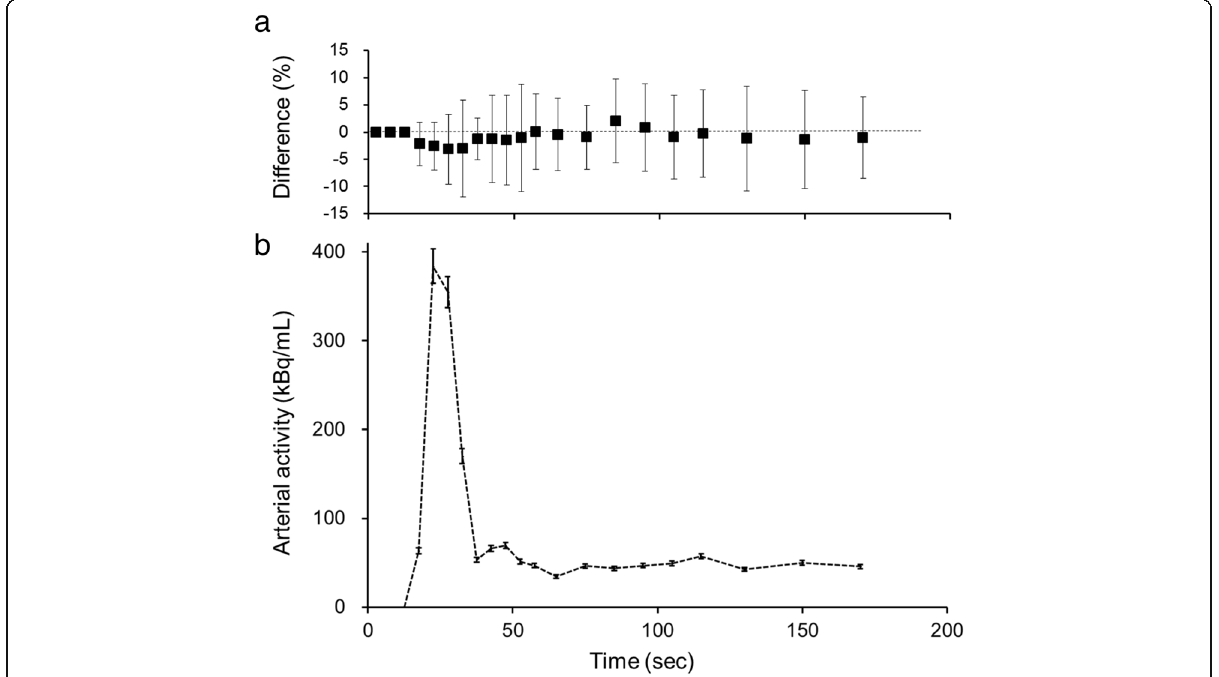
Fig. 3 a Average percentage differences in arterial radioactivity at each point of dynamic PET frames. The difference of each point was less than 5%, although variance (SD) was about ± 10%. b A representative IDIF curve from a patient is presented at the bottom. The error bars were calculated from the average difference of each time point. Estimation errors are small, especially in the phase of low radioactivity